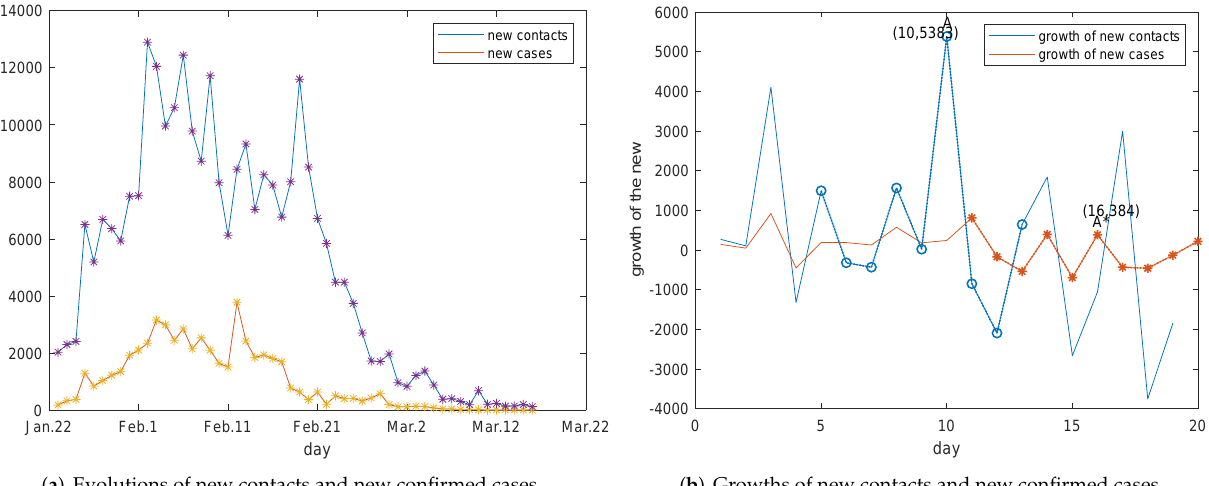
Figure 2. Investigations on close contacts and confirmed cases. ( a ) There is a similar evolution trend in the number of new confirmed cases and that of new tracked close contacts. ( b ) There is a maximum growth in the number of new confirmed cases at A ∗ which is 6 days behind A . A corresponds to the maximum growth in the number of new tracked close